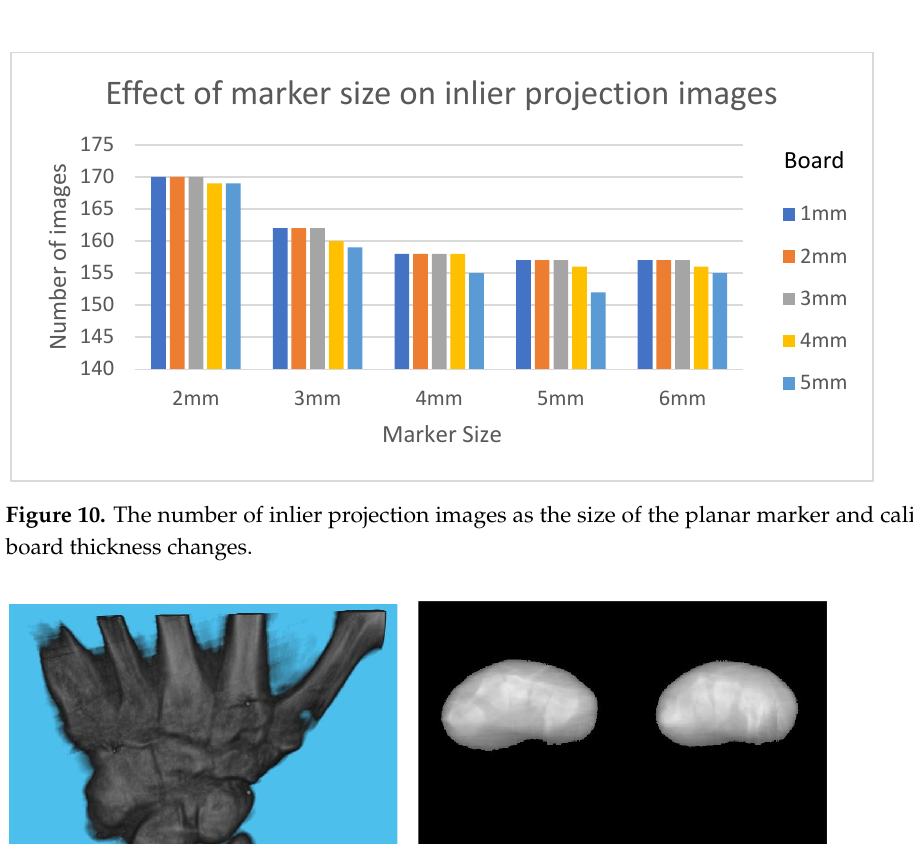
Figure 9. Marker detection error according to marker size ( left ). Calibration interest point detection error according to board thickness ( right ).